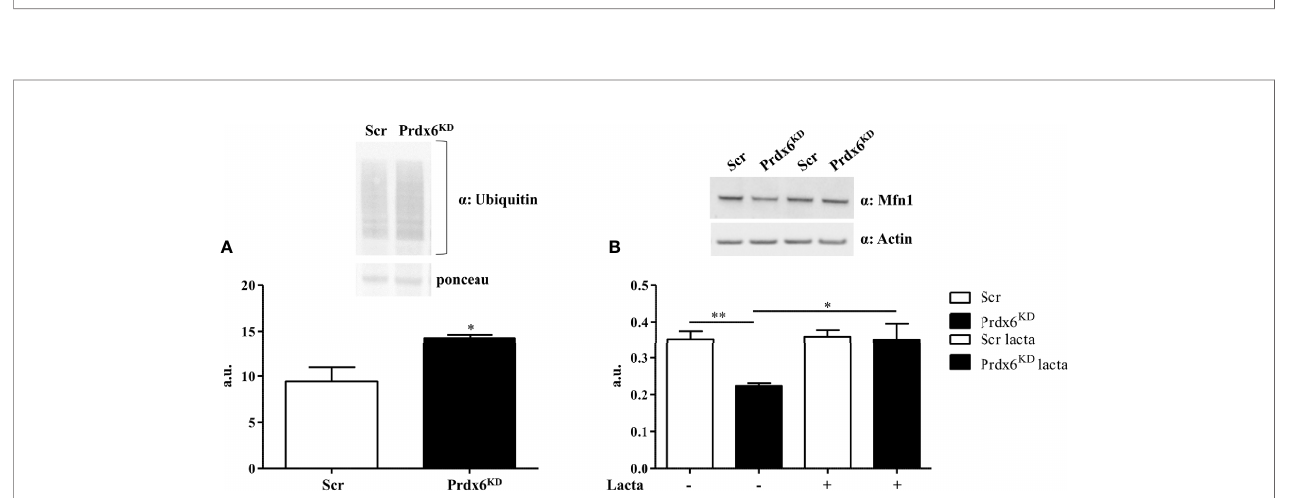
FIGURE 5 | The ubiquitin – proteasome (UP) system mediates Mfn1 degradation in Prdx6 KD cells. Fifty micrograms of Prdx6KD (black- fi lled bar) and Scr (white- fi lled bar) total protein lysates was immunoblotted with a speci fi c antibody against ubiquitin (A) , and values were normalized by using Ponceau S staining. The UP system was inhibited by lactacystin (B) . All values were normalized with actin as a loading control. All values are expressed as mean ± SEM. *p < 0.05, **p < 0.01 (n = 5). a.u., arbitrary